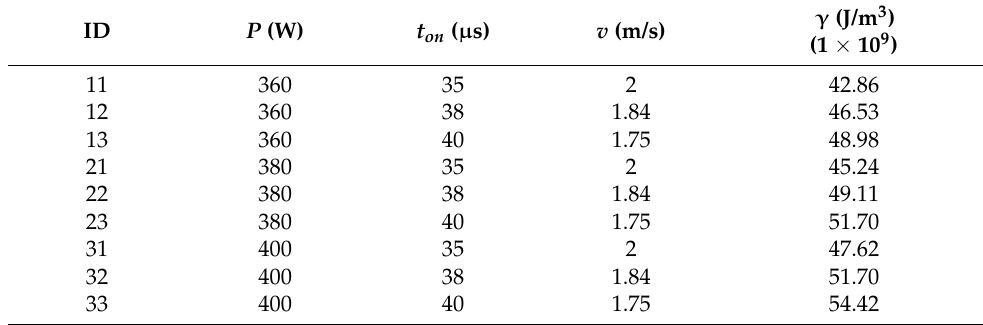
Figure 2. Experimental set-up for the selective laser melting of In718 cubes. The main elements of the experimental set-up are marked: (1) overflow, (2) build plate, (3) powder feed container, (4) recoater, (5) inert atmosphere; argon, (6) laser and optics system; Nd: YAG fiber laser, and (7) building chamber. Table 6. Fabrication parameter values.